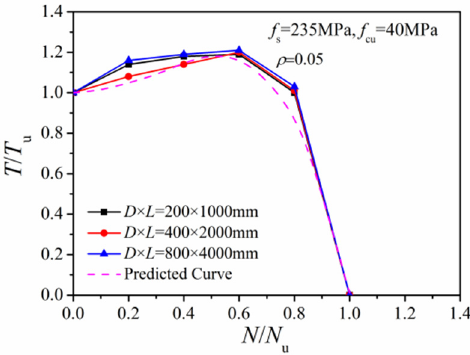
Figure 13. Effect of different slenderness ratios.